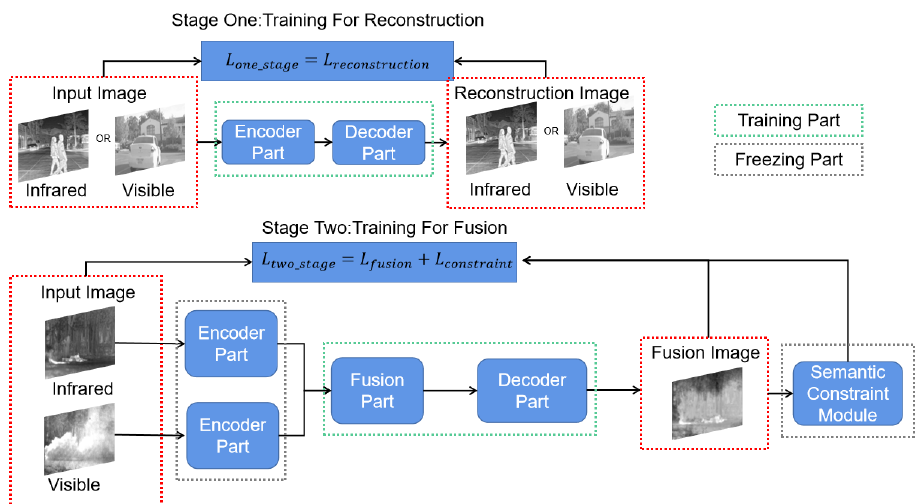
Figure 2. An illustration of our multi-stage training approach, which contains multiple training stages, with the encoder, decoder, and feature fusion parts (involved in the second stage).